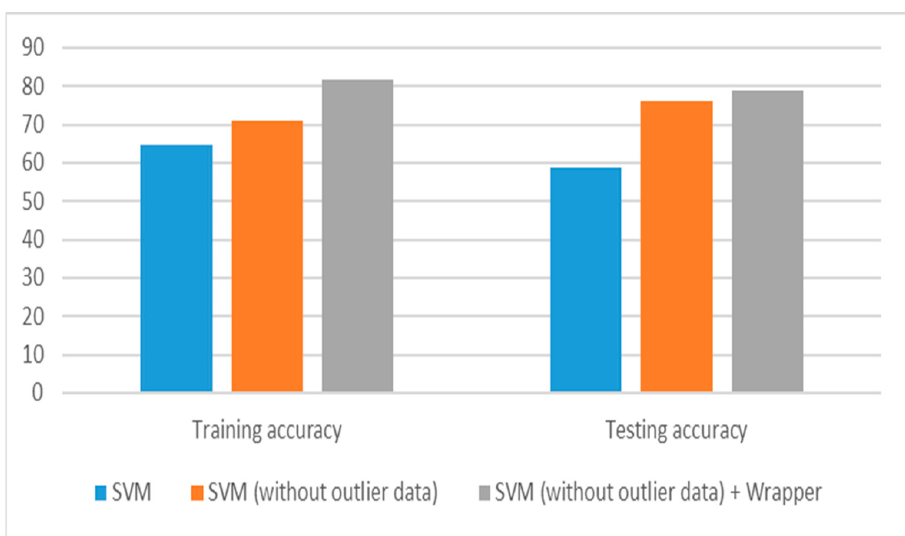
Figure 3. The classification accuracy of the SVM algorithm through the proposed system phases to predict the total deaths.